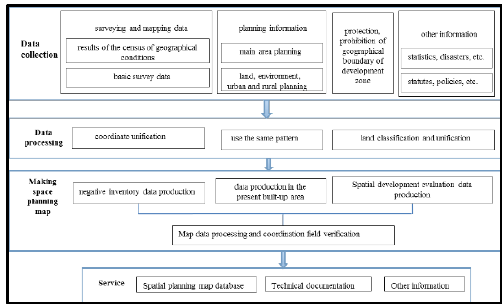
Table 3. Spatial planning map compilation